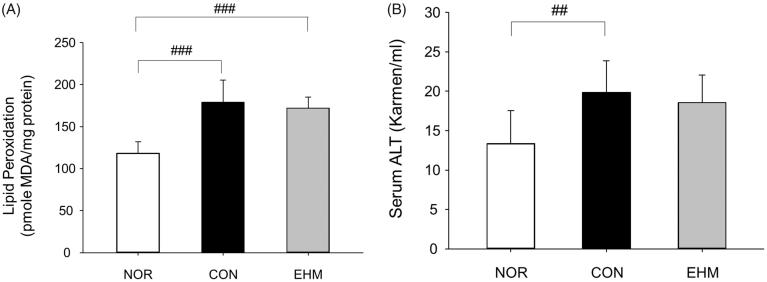
Effects of EHM on lipid peroxidation and blood alanine aminotransferase (ALT) levels in hyperlipidemic mice. Lipid peroxidation in liver tissues and blood ALT levels were determined via spectrophotometry. NOR: normal diet-fed control mice (n = 8), CON: HFD-fed hyperlipidaemic mice (n = 8), EHM: HFD-fed and EHM-administered mice (n = 8). Values are presented as means ± SD. ##p < 0.01 and ###p < 0.001 compared to the NOR group.